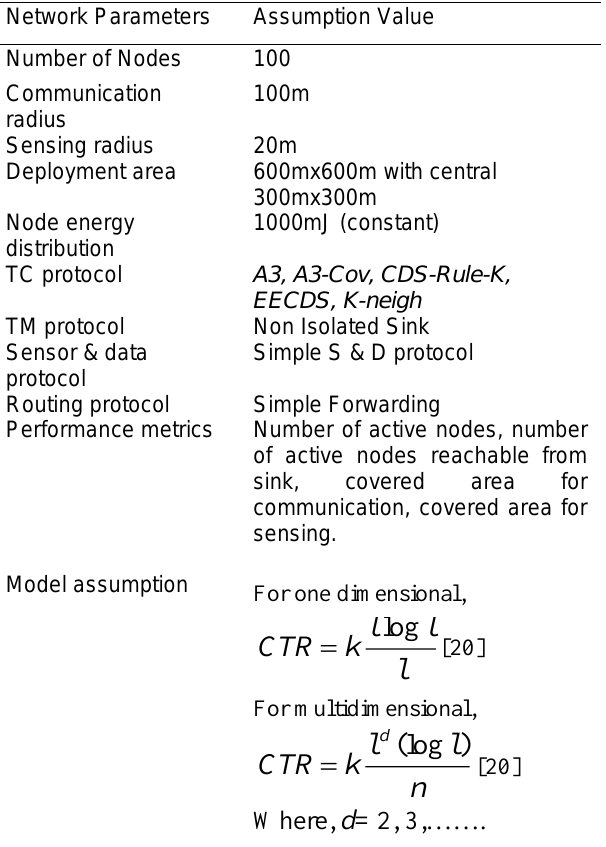
Table 4. Experimental setup for lifetime analysis of sparse topology sensor